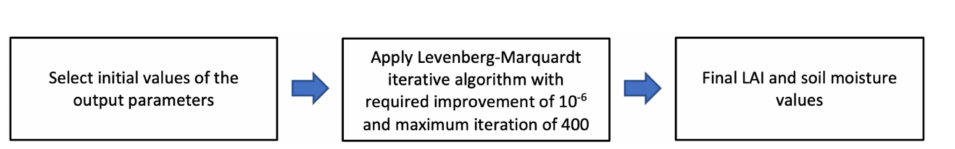
Figure 2. Flowchart of the inversion of the water cloud model